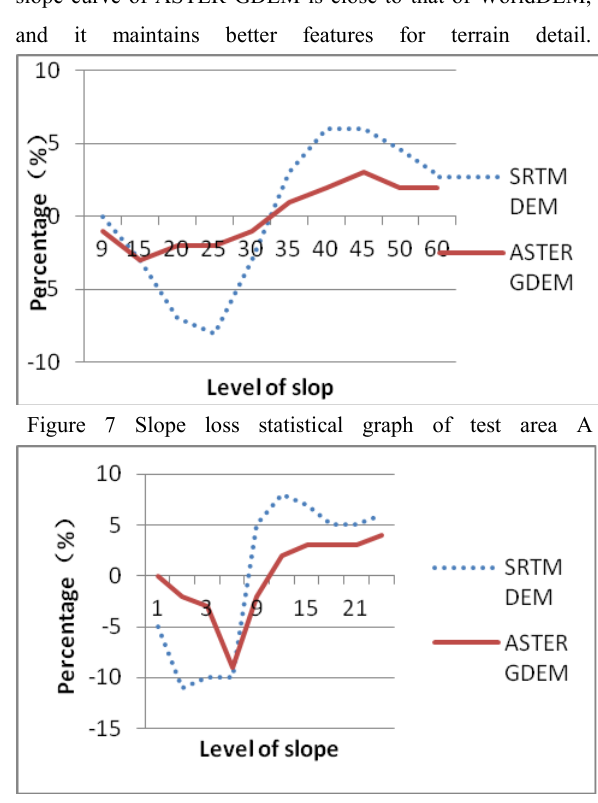
Figure 8 Slope loss statistical graph of test areaB